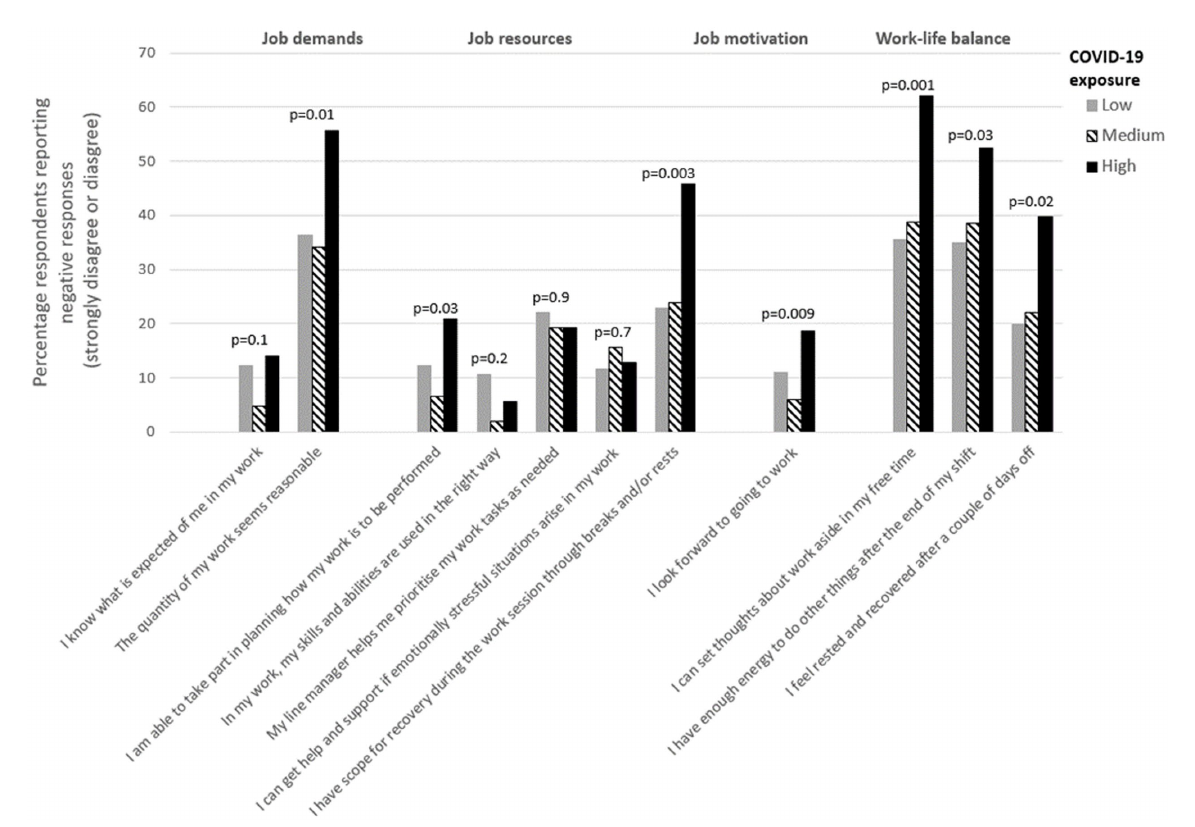
FIGURE 2 Managers reporting a negative situation during the first wave of the pandemic, stratified by COVID-19 exposure. The percentage of managers who strongly disagreed or disagreed with the statements in the survey regarding job demands, job resources, job motivation and work-life balance in the COVID-19 survey, thus reporting a negative situation during the first wave of the pandemic (in spring 2020), stratified by COVID-19 exposure group. Low, medium and high COVID-19 exposure at the department represents <32%, between 32 and 63% and >63% of the employees that cared for COVID-19